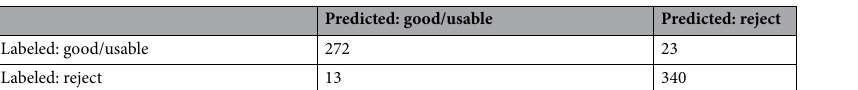
Table 2. Confusion matrix of image quality classification for DR4 images of EyeQ dataset using our approach. The quality threshold is set to 1.50 and there are 13 images mislabeled as “Reject” quality by human graders. Our method is unable to correctly classify 23 images with decreased vessel